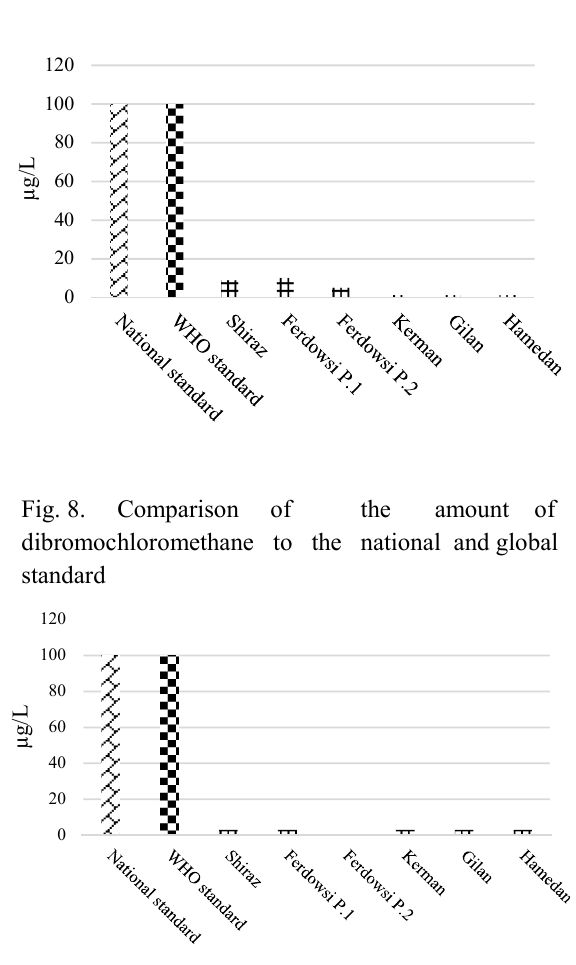
Fig. 6. Comparison of the amount of chloroform to the national and global standard